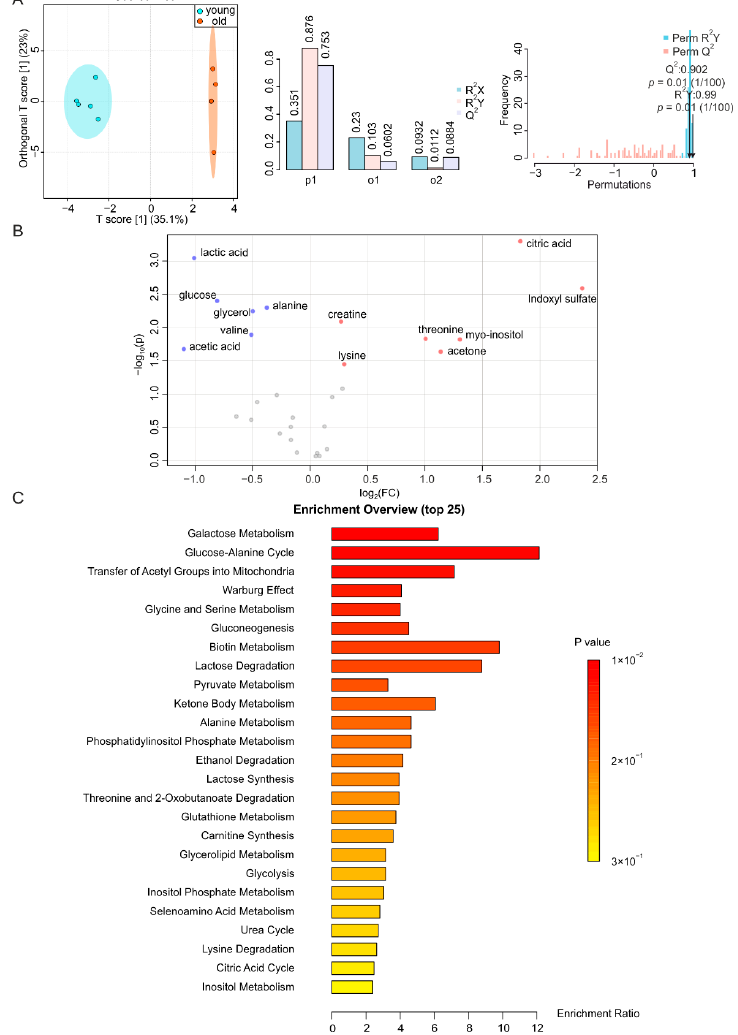
Figure 1. NMR-based metabolomics analysis of plasma. ( A ) O-PLS-DA plot of plasma samples from young (blue) and old (orange) mice (left), with n = 5 each, and the permutation between predictive component (p1) and two orthogonal components (o1, o2) with cross-validated R 2 X, R 2 Y, and Q 2 coefficients (middle), and histogram showing the permutation test with permutation number n = 100 (right). Note in the O-PLS-DA plot (left panel), the 2 data points with an orthogonal T-score of 0 overlap. ( B ) Volcano plot of metabolites with different abundances between plasma from young and aged mice. Increased (red) and decreased (blue) metabolites illustrate significant fold changes during aging, while grey dots denote insignificantly changed metabolites. ( C ) Metabolite set enrichment analysis (MSEA) of affected metabolites pointing out their physiological relevance.